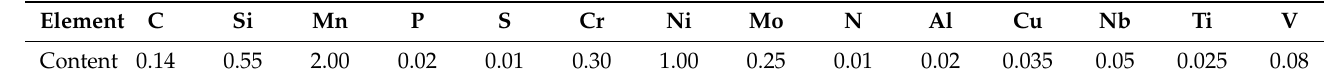
Table 1. Chemical composition (wt%) of the thick steel plate.